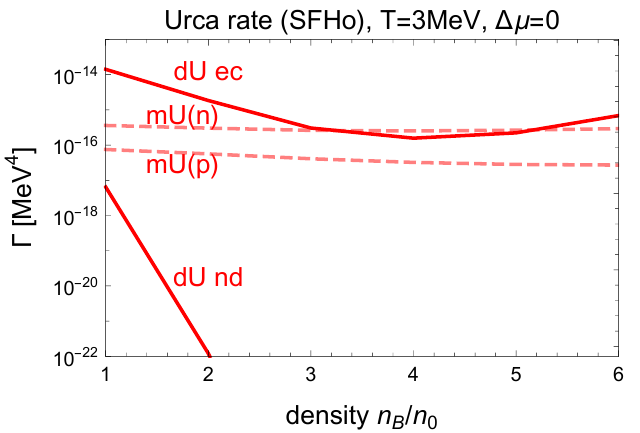
Figure 10. Urca rates calculated using the SFHo EoS at T = 3MeV. Because ∆ µ = 0 there is a large mismatch between the direct Urca rates for neutron decay and electron capture. Modified Urca (with neutron spectator (n) and proton spectator (p)) rates are calculated in the Fermi surface approximation and therefore match